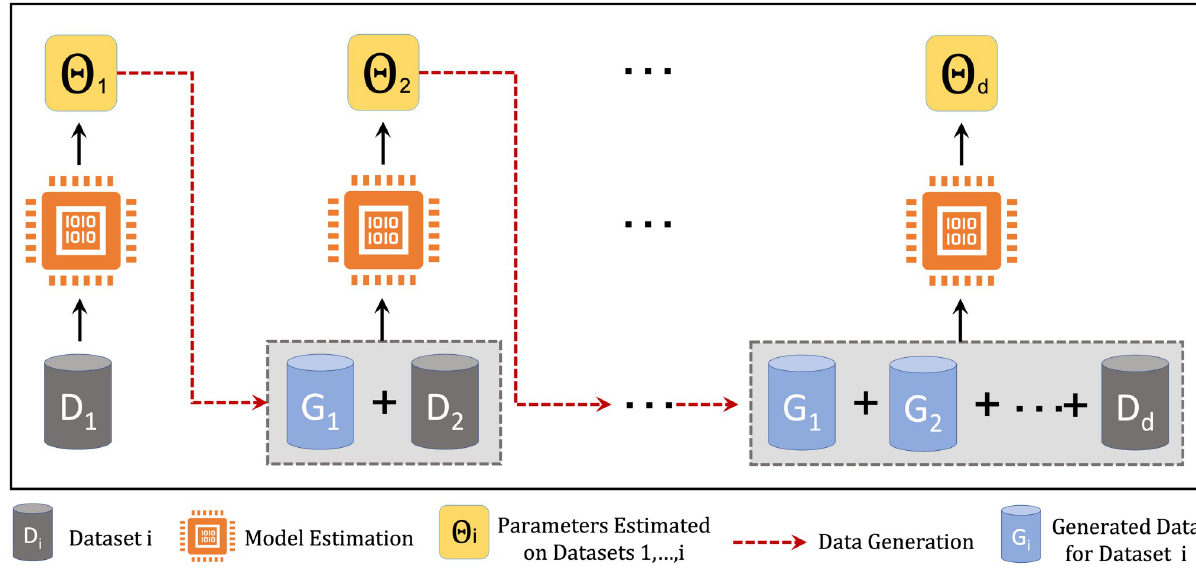
Fig 3. Model extension loop in multi-site normative modeling using HBR. The synthetic data generated for stages 1, ... , i − 1 are used to estimate the model parameters at stage i . Model extension provides the possibility of updating the model parameters over time, and parameter estimation on decentralized